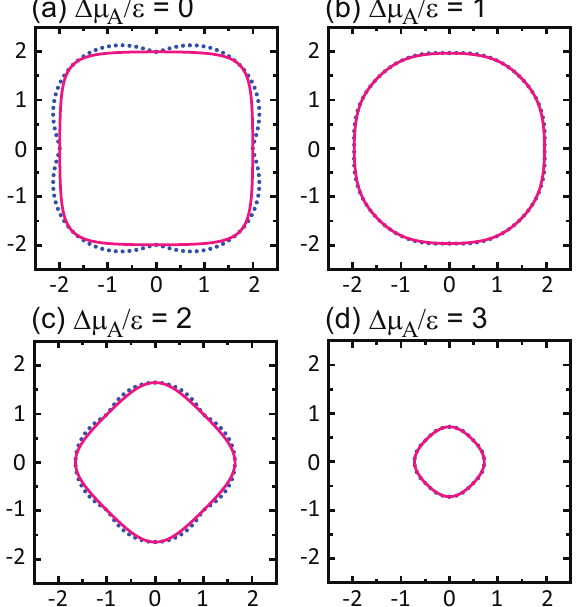
Figure 7. (001) facet shapes on the ECS (red full lines) and polar graphs of step tension γ ( φ ) (blue dotted lines) calculated using the IPW method [75,76] based on the 2D lattice gas model. ∆ µ A / (cid:101) = ( a ) 0.0, ( b ) 1.0, ( c ) 2.0, and ( d ) 3.0. The values have units of J ( = (cid:101) /2). k B T / (cid:101) = 0.2. These figures are reprinted